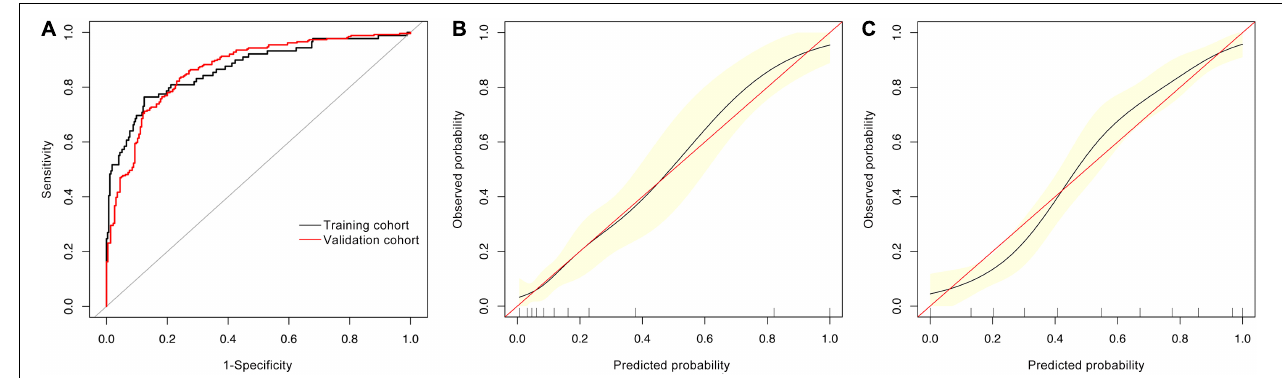
FIGURE 2 | ROC and calibrating curves for diagnosing MCI in T2DM patients. By combining age, ApoE ε 4 genotype, olfactory score, platelet rGSK-3 β , and plasma A β 1-42/A β 1-40, we received AUCs of 0.869 (95% CI: 0.822–0.914) and 0.867 (95% CI: 0.835–0.899) in the training and validation cohorts, respectively (A) with high diagnosed probability [ (B) the training cohort; (C) the validation cohort].